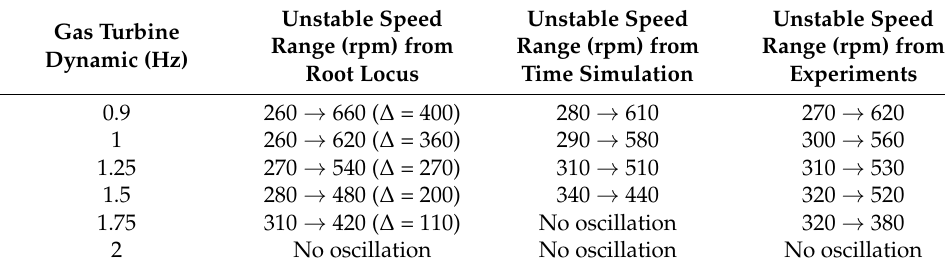
Table 2. Results of the different means of study for different gas turbine control dynamics.